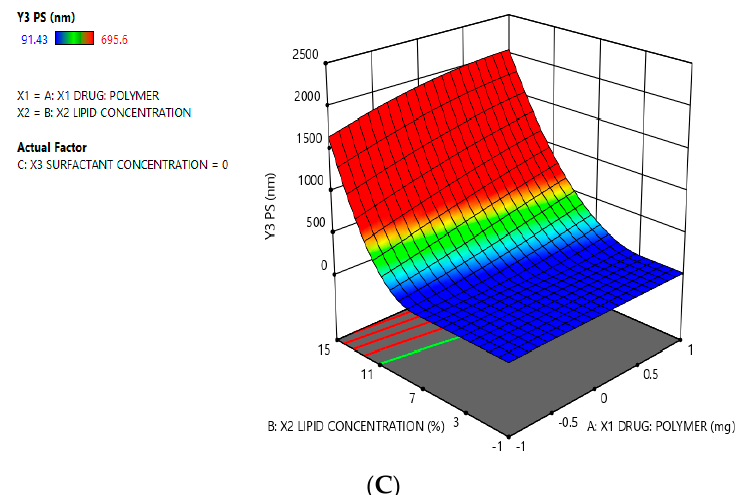
Figure 2. Effect of specified variables on hesperidin nanoformulations as depicted in three-dimensional response surface diagrams; ( A )—%Entrapment efficiency of optimized formulation; ( B )—%Drug release of optimized formulation; ( C )—Particle size of optimized formulation.